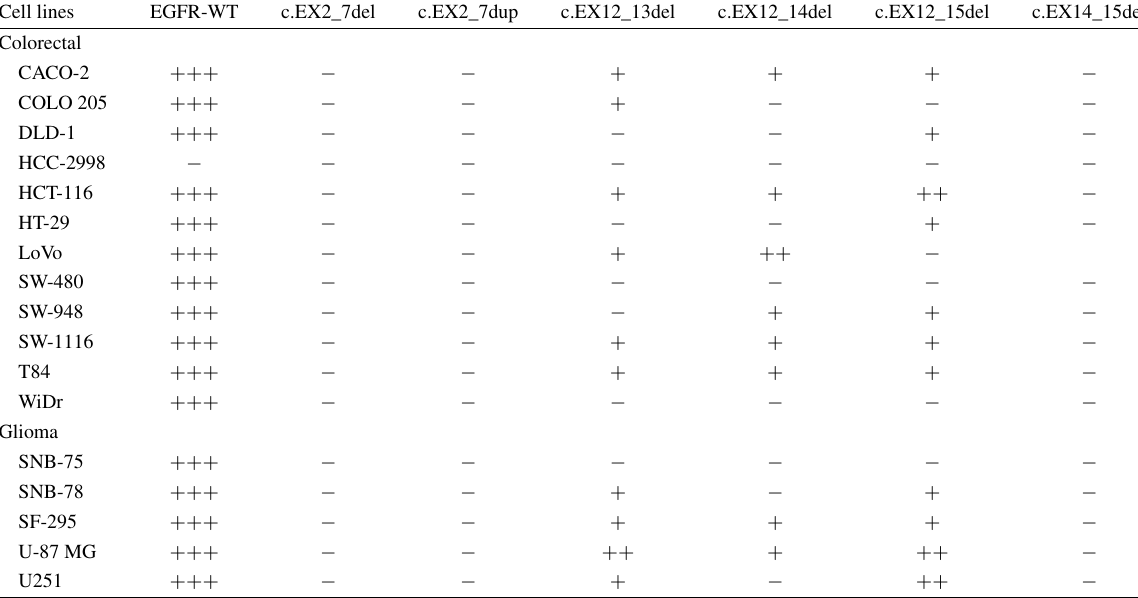
EGFR expression analysis of colorectal and glioma cell